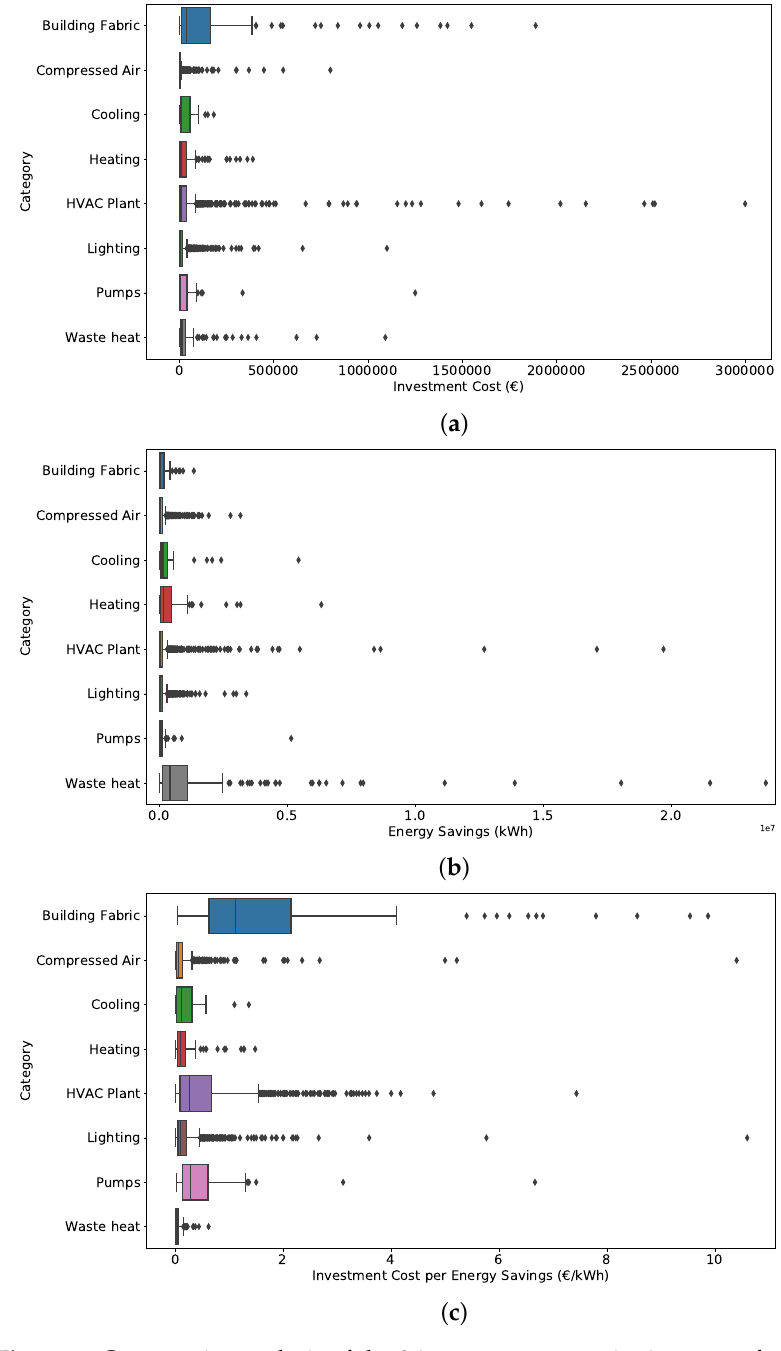
Figure 3. Comparative analysis of the 8 investment categories in terms of cost, energy savings, and investment efficiency (defined as investment cost per energy savings). ( a ) Investment cost per category. ( b ) Energy savings per category. ( c ) Investment efficiency per